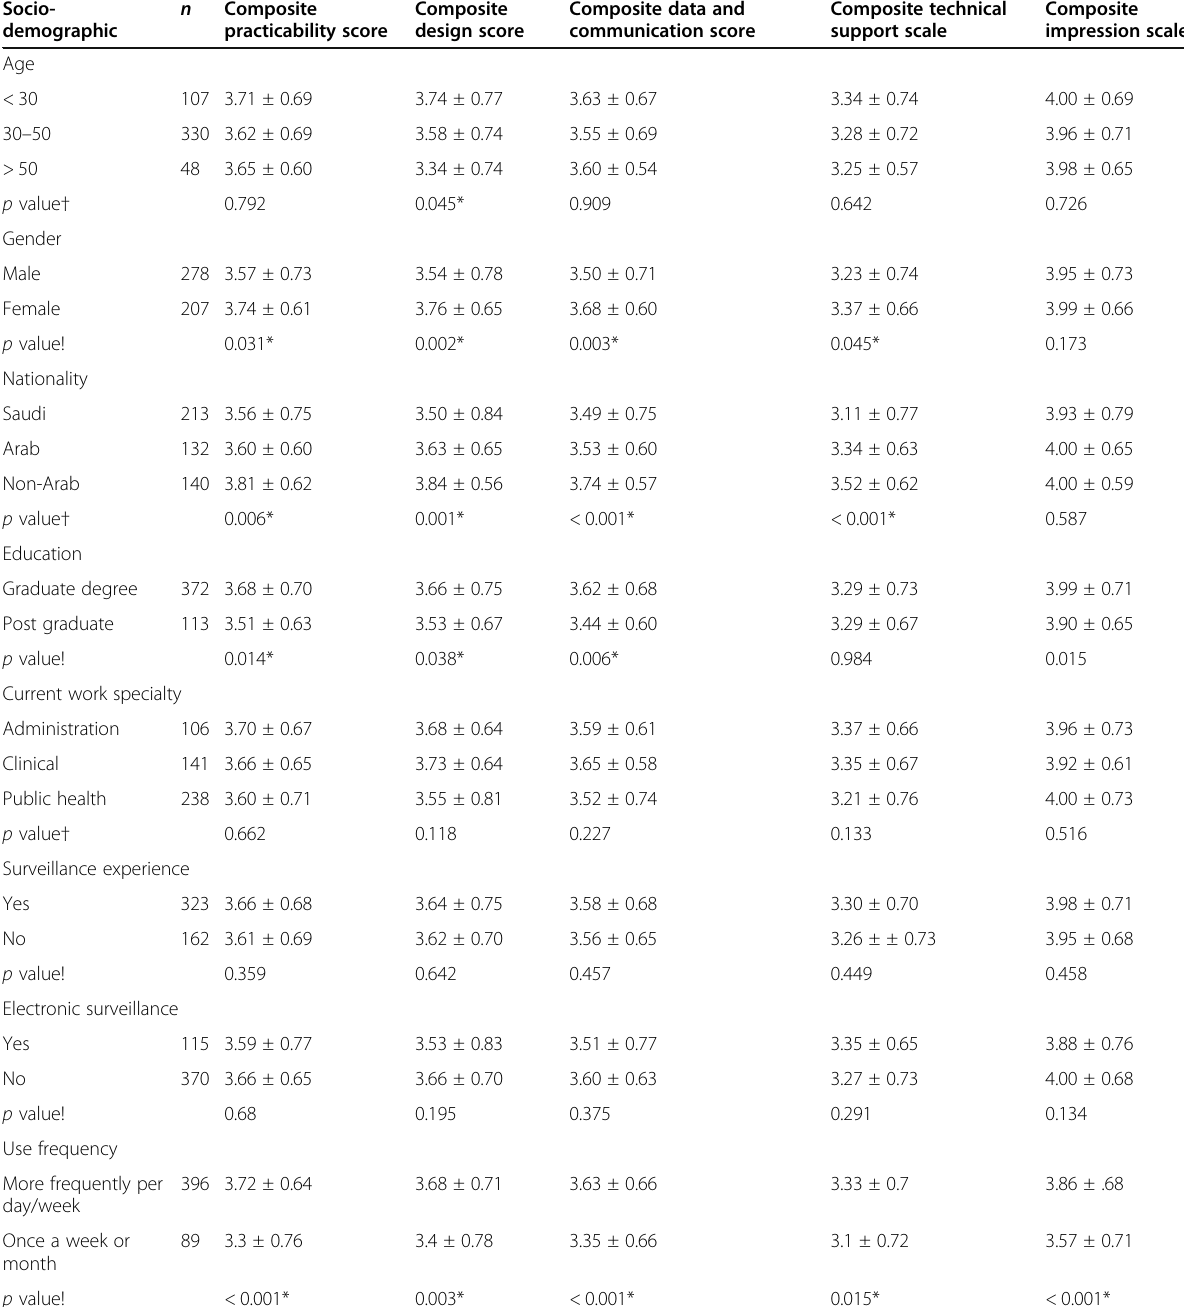
Table 1 Characteristics of the study participants in relation to the composites scores of practicability, design, data and communication, technical support, and general impression, KSA,